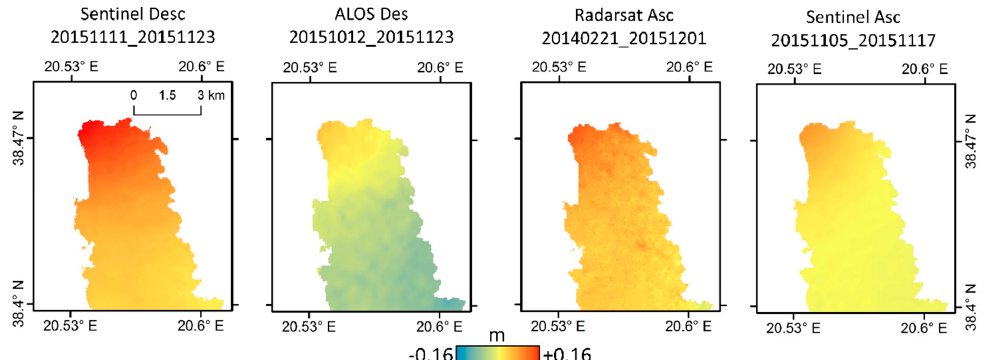
Figure 3. Detail of the unwrapped interferograms used in this study, showing the deformation at the northern tip of Cephalonia (blue dashed rectangle in Figure 2). The displacement at the tip of Cephalonia is apparent in all interferograms and it is this which offers new constraints on the fault segmentation of the area.